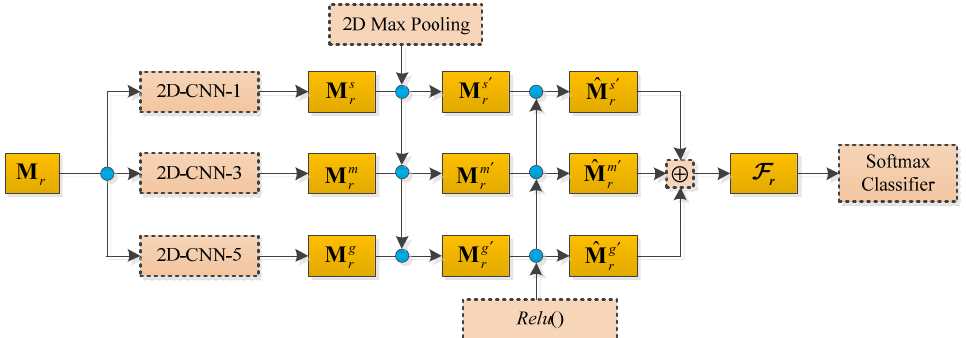
Figure 2. Multichannel two-dimensional convolutional neural network.